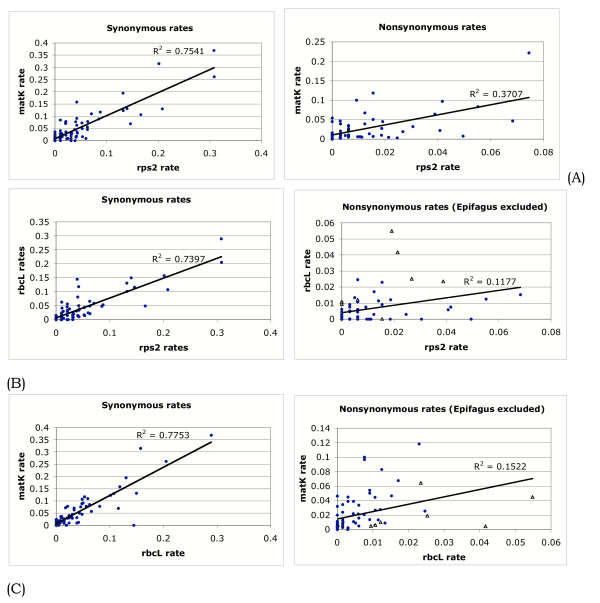
Correlations across each possible pair of genes for synonymous and nonsynonymous rates. (A) rps2 versus matK. (B) rps2 versus rbcL. (C) matK versus rbcL. All nonsynonymous comparisons involving rbcL pseudogenes are indicated with a hollow triangle.